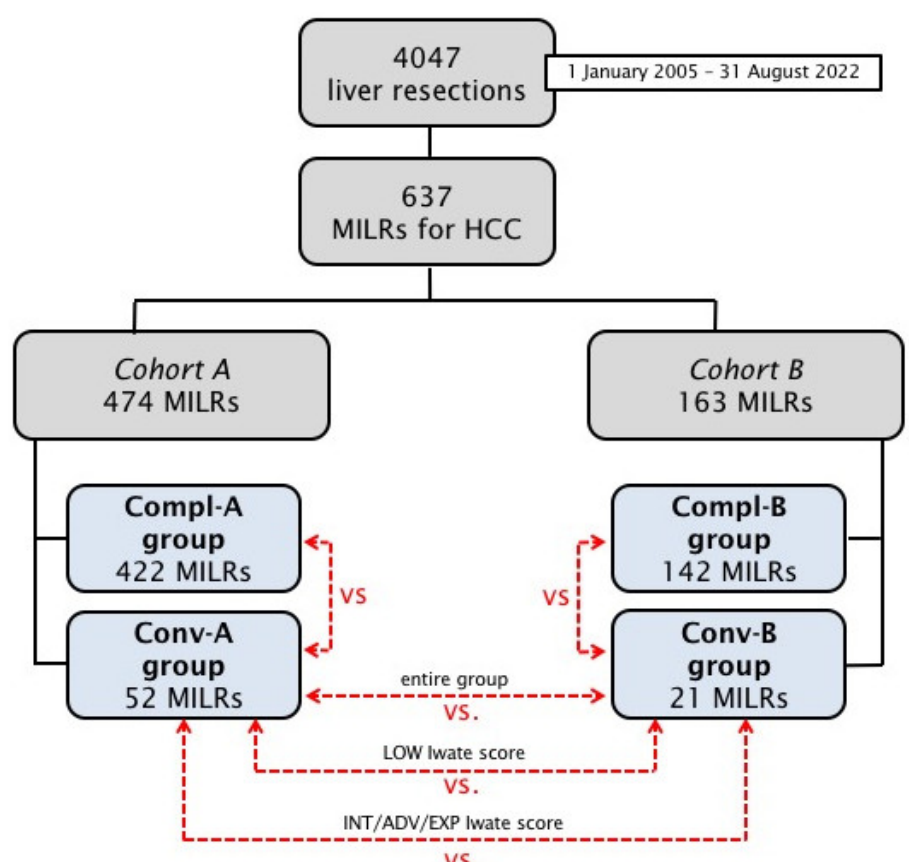
Figure 1. The study design. HCC stands for hepatocellular carcinoma. MILR stands for minimally invasive liver resection.